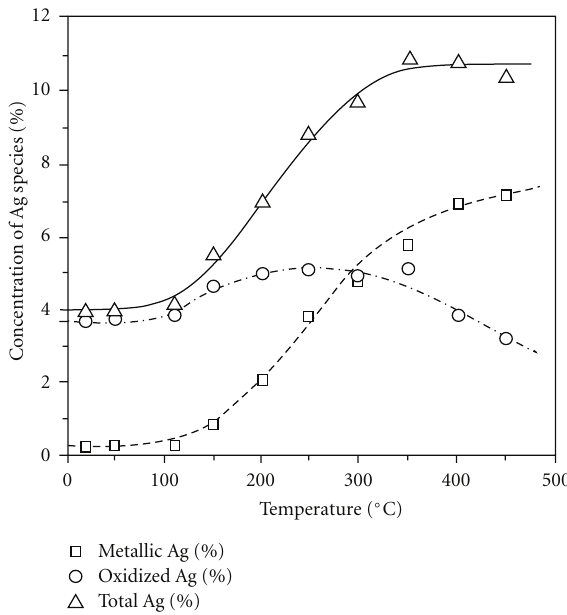
Figure 3: The concentration changes of total, metallic, and oxidized Ag on surface at di ff erent sample temperatures. A three-step di ff usion process was